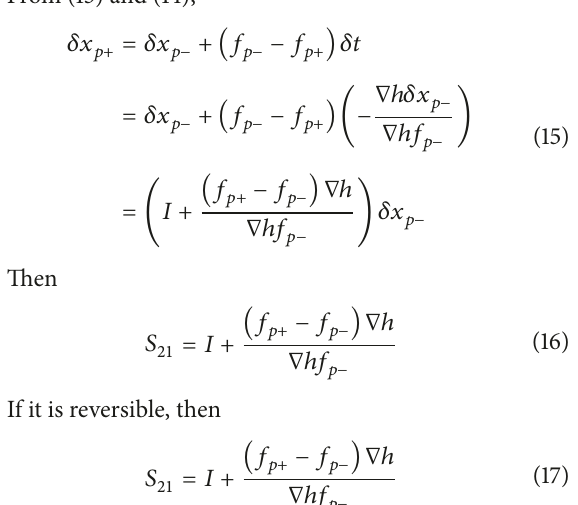
Figure 2: The basic mapping.